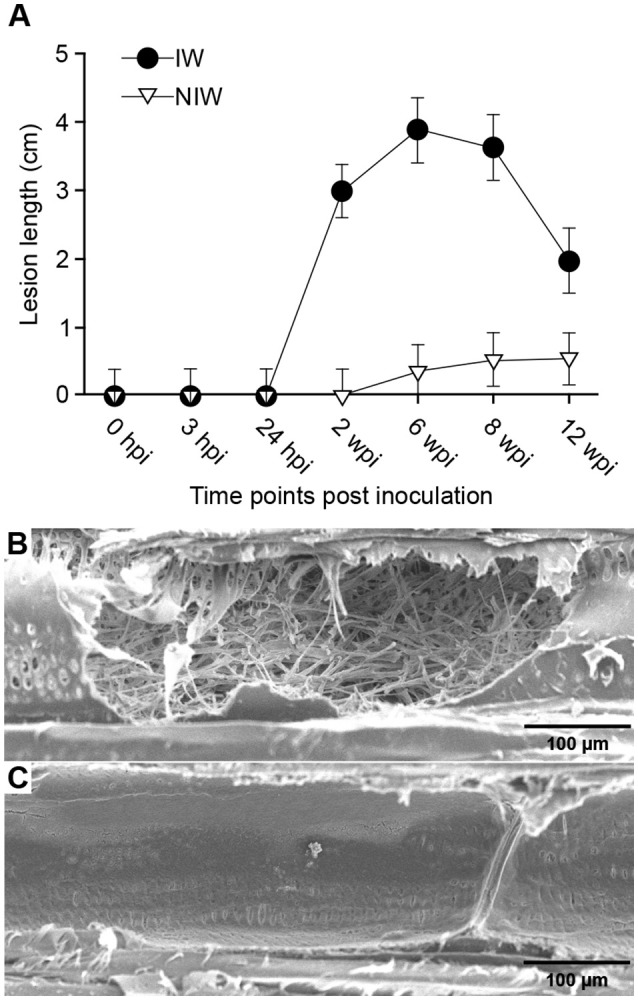
Lesion development and pathogen localization in N. parvum infected woody stems. (A) Pattern of lesion development during the 12-week time course. Error bars are 95% confidence limits. Points with overlapping error bars are not significantly different (Tukey post-hoc test, P < 0.05, α = 0.05). NINW plants were not included in the ANOVA because lesion lengths were equal to 0 at all sampling time points. SEM micrographs of tangential longitudinal sections of open secondary xylem vessels of infected plants (B) and wounded and non-inoculated plants (C). Panel B shows a vessel lumen extensively colonized by N. parvum hyphae and panel C shows an empty vessel lumen with a thin coating of gels on the lateral wall. Bar, 100 μm.